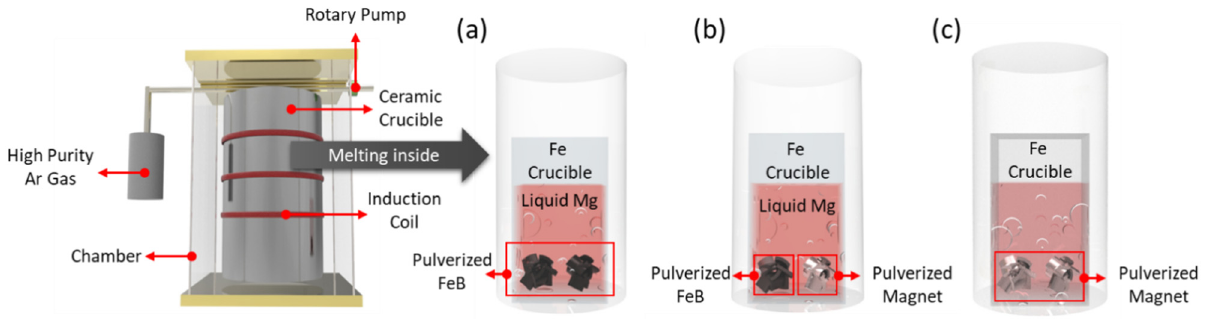
Figure 1. Schematics of the reaction experiments of ( a ) Mg–FeB, ( b ) Mg–FeB–magnet, and ( c ) conventional LME process.